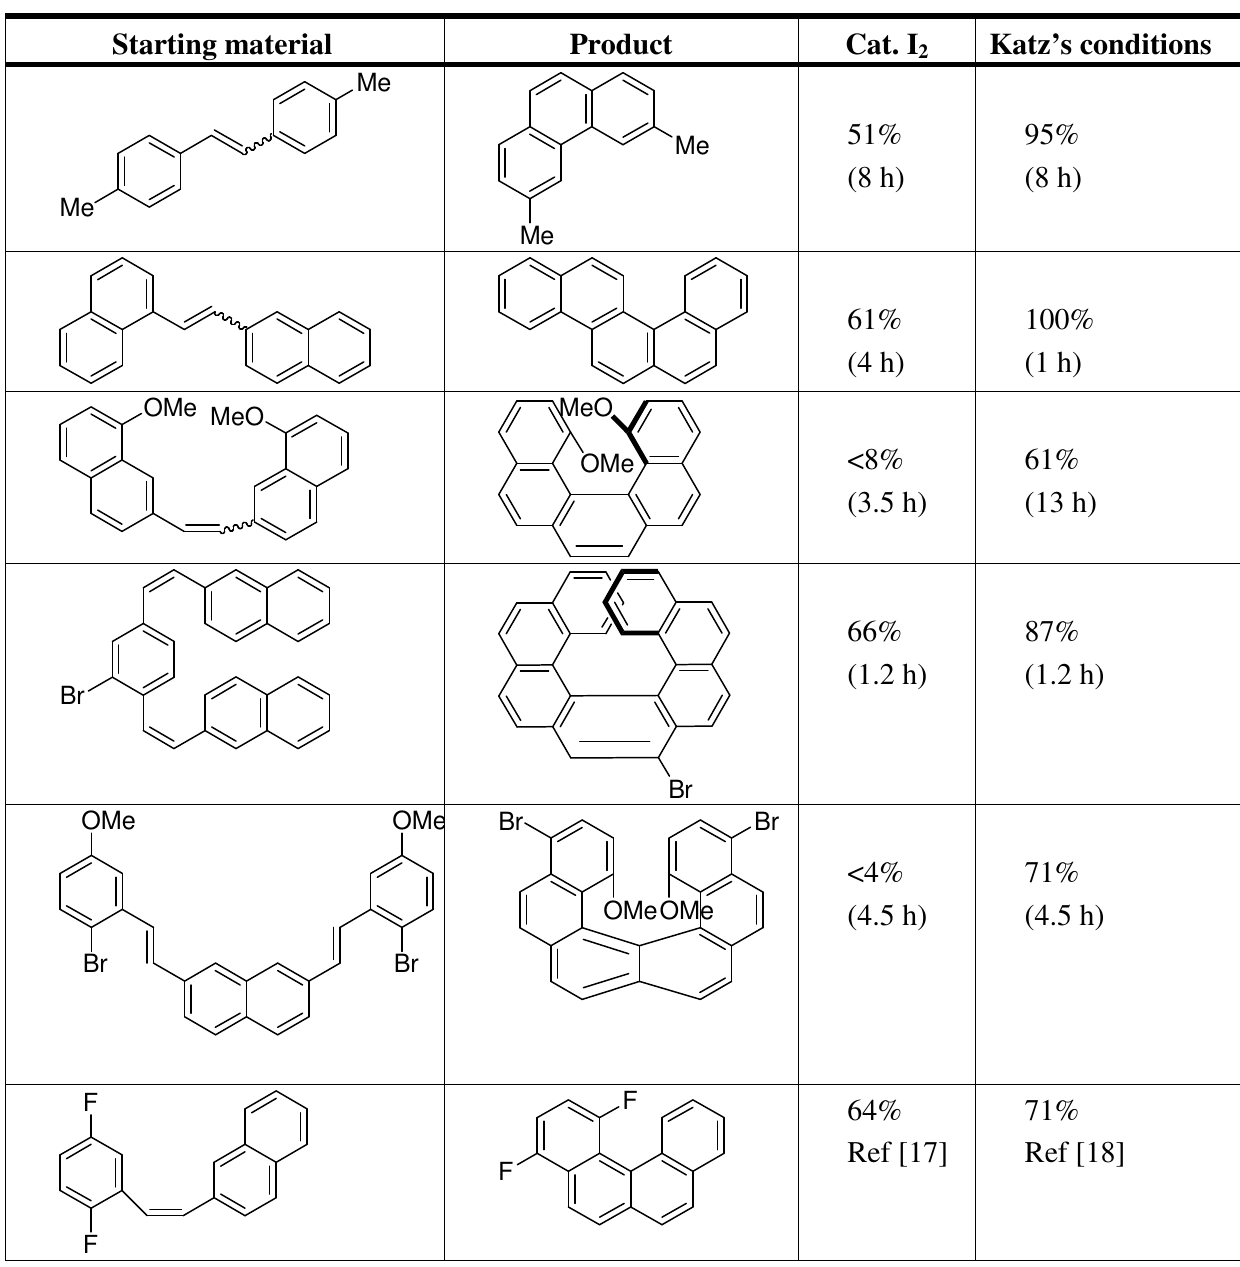
Table 1. Comparison between catalytic iodine/oxygen and Katz’s conditions. Most examples are from ref